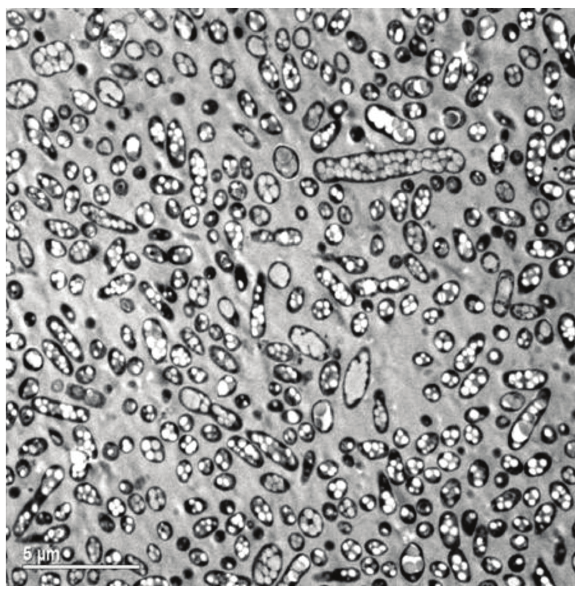
Fig. 1 – Electron microscope image of PHA-rich C. necator cells. The PHA content is well visible as white inclusion bodies (“carbonosomes”). Magnification: 20,000. Image kindly pro- vided by E. Ingolić, FELMI-ZFE